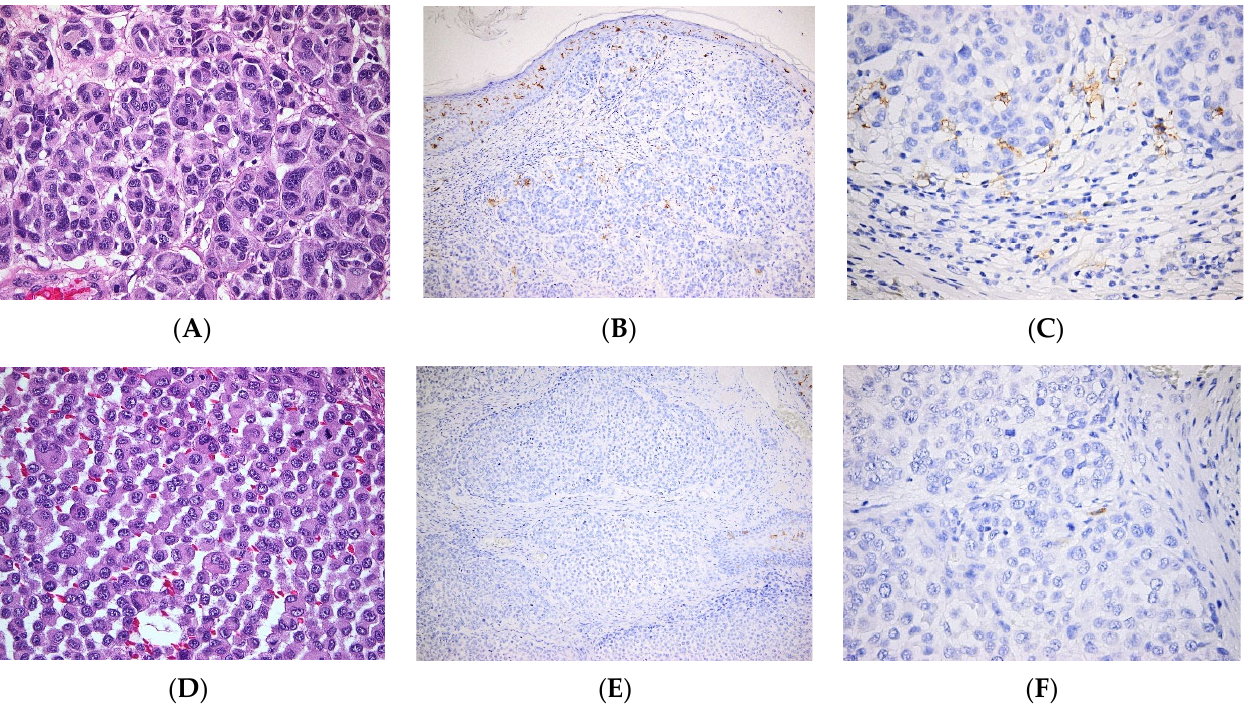
Figure 5. Presence of Langerhans cells in nodular melanoma with various phenotypic appearances. ( A ). Small nests of highly pleomorphic melanocytes. HE × 400. ( B ). Relatively frequent Langerhans cells within the tumor mass. CD1a × 100. ( C ). Numerous Langerhans cells present within the tumor nests and peritumoral inflammatory infiltrate. CD1a × 400. ( D ). Large nests of moderately pleomorphic melanocytes with marked discohesivity. HE × 100. ( E ). Absence of Langerhans cells within the tumor; several Langerhans cells observed in the hair follicle (positive control). CD1a × 100. ( F ). Absence of Langerhans cells within the tumor; one single positive cell observed in the inflammatory infiltrate. CD1a × 400.